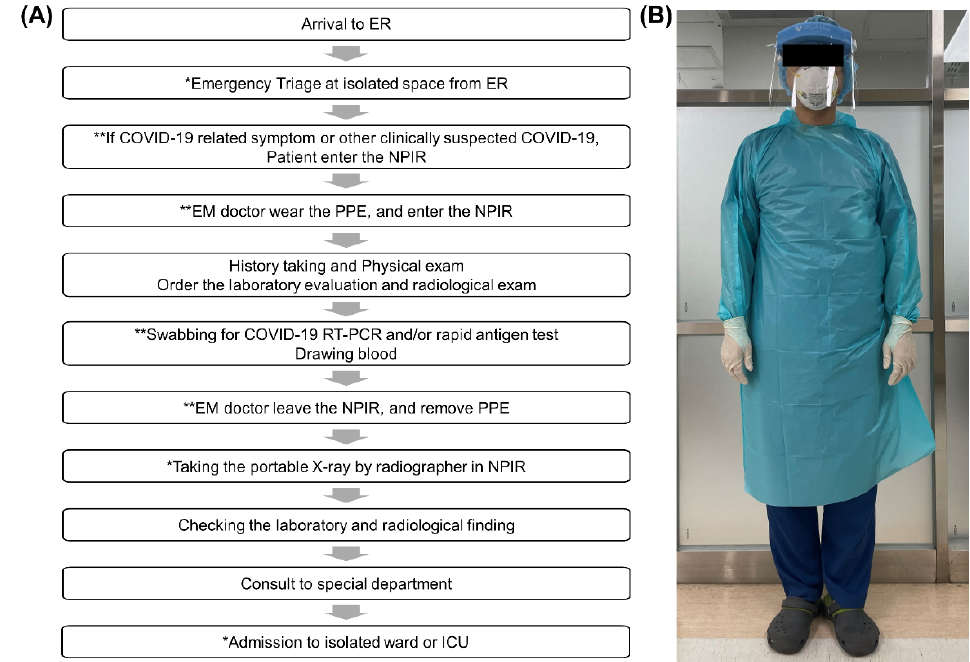
Figure 1. Clinical algorithm for patients visiting the ED, and a picture of an ED worker wearing PPE after the COVID-19 pandemic. A star (*) indicates changes in the process, and a double star (**) indicates an addition in the process with regard to the previous clinical pathway. (A) Clinical pathway. (B) ED worker wearing PPE. Acronyms: ED, emergency department; COVID-19, coronavirus disease; EM, emergency medicine; NPIR, negative pressure isolation room; RT-PCR, reverse transcription-polymerase chain reaction; ICU, intensive care unit; ER; emergency room; and PPE; personal protective equipment.